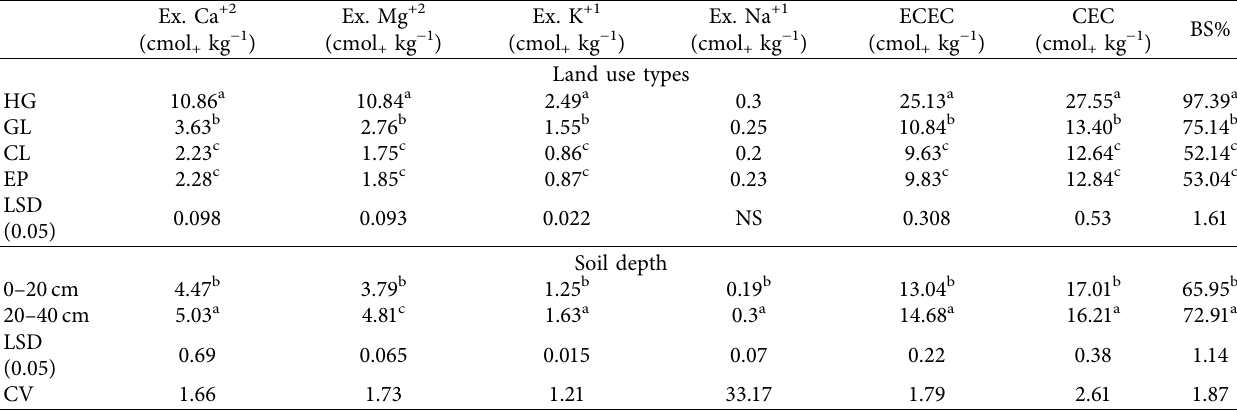
Table 4: Main efects of land use and soil depth on soil exchangeable cations and base saturation percentage of the soils in the Hojje watershed ( N � 24).